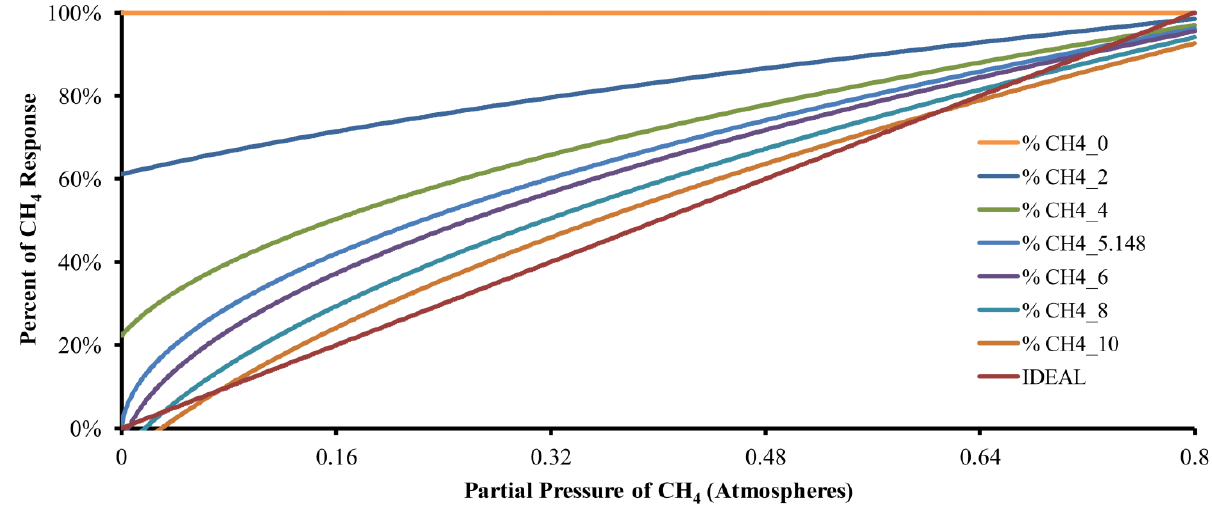
Figure 3. The response of the mathematical model with different quantities of absortion liquid (in moles). CH4_0 with 0 moles, CH4_2 with 2 moles, CH4_4 with 4 moles, CH4_5.148 with 5.148 moles, CH4_6 with 6 moles, CH4_8 with 8 moles and CH4_10 with 10 moles. In addition, an IDEAL plot is included for a theoretical perfect